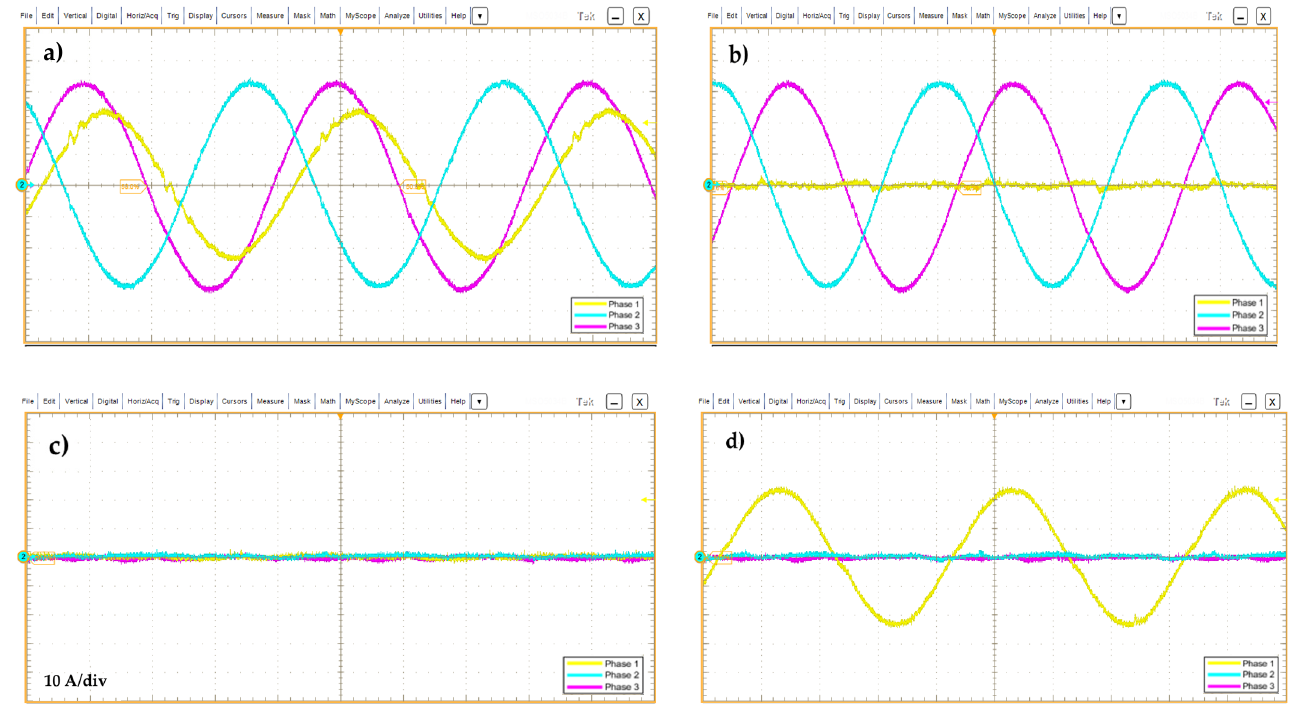
Figure 12. Programmable AC source currents (measured at PCC point): ( a ) AC source loaded without AC/DC converter connection, ( b ) connected AC/DC converter operating in reactive power compensation mode, and ( c ) reactive power compensation in the idle state of the AC source. ( d ) The coverage of reactive current demand by the AC/DC converter.